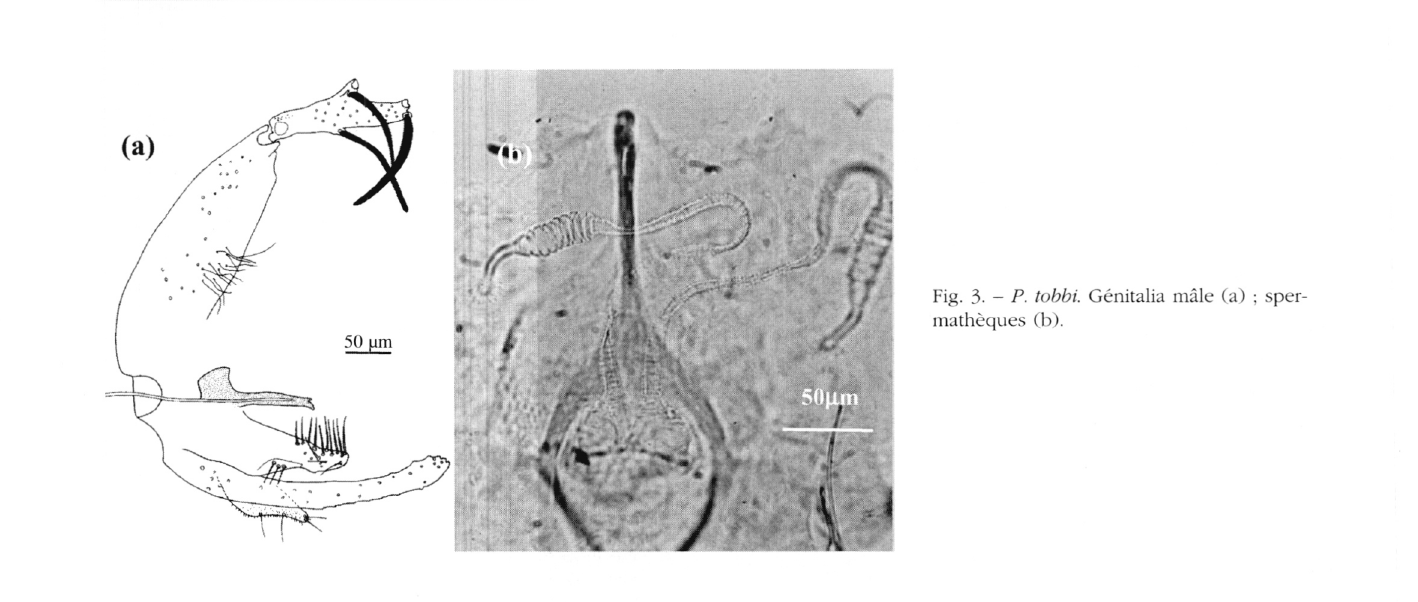
Fig. 3. - P tobbi. Génitalia mâle (a) ; sper- mathèques